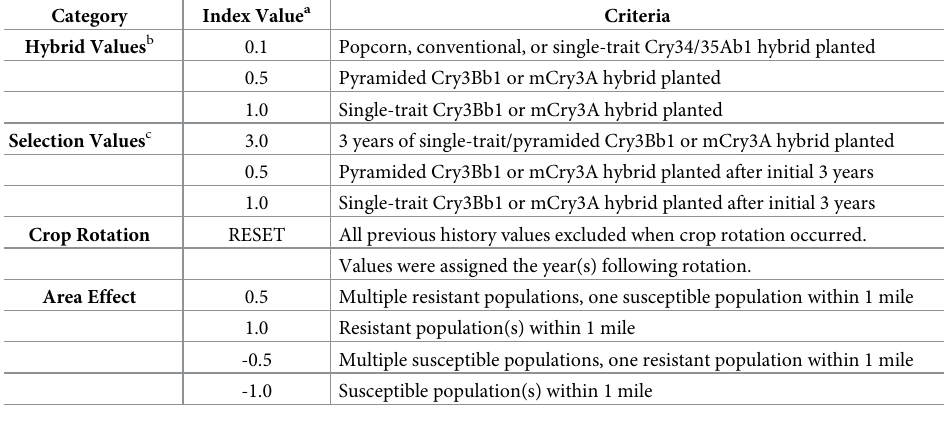
Table 2. Field history index values and criteria used to assign values to individual fields.